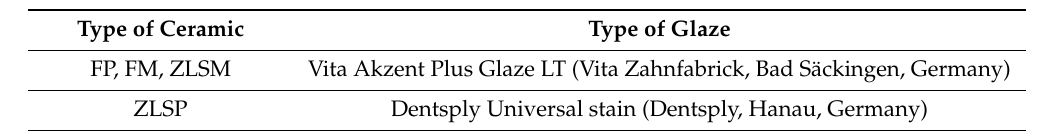
Table 3. Type of glaze for each ceramic.